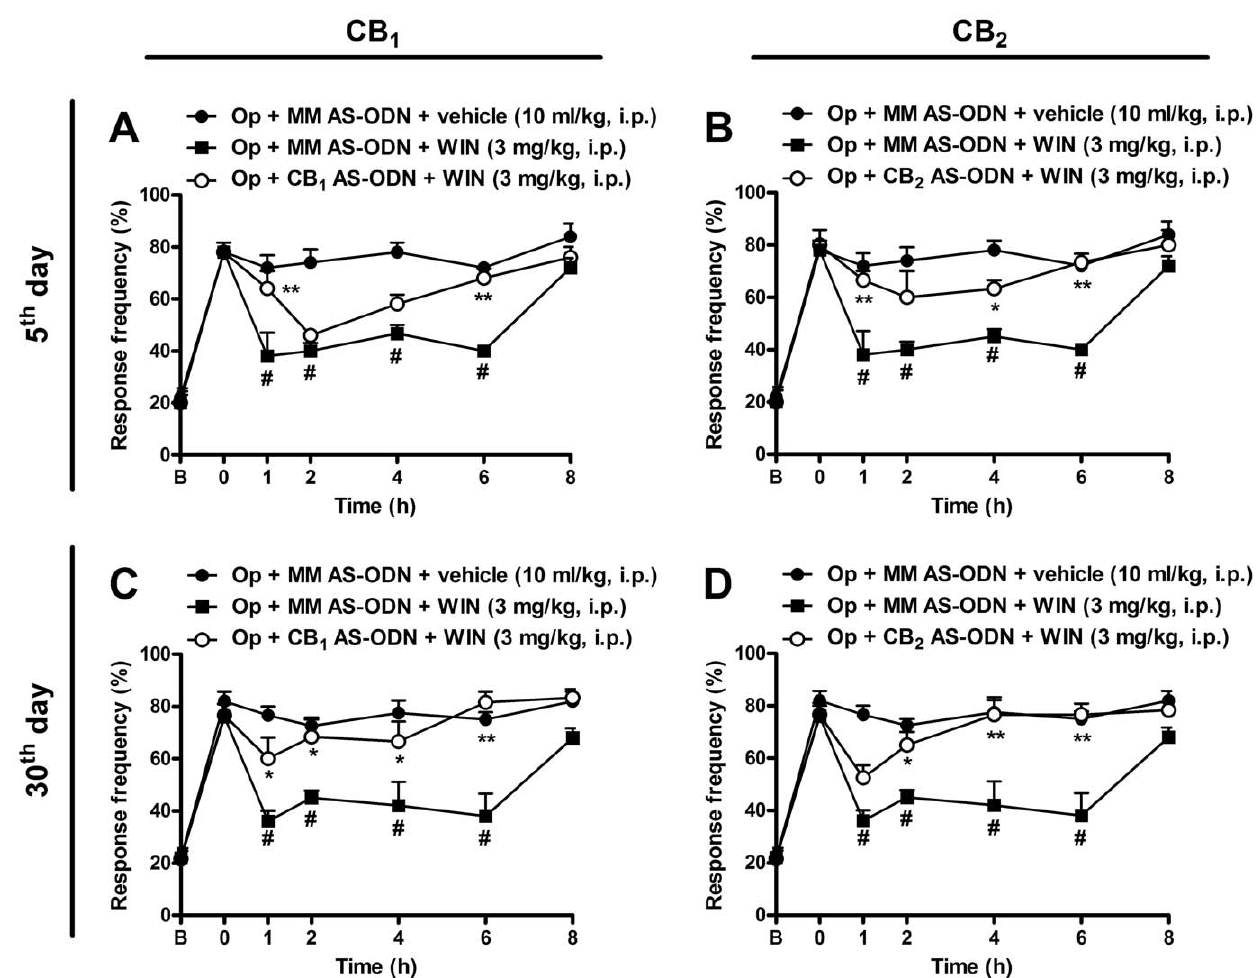
Figure 9. Effect of treatment with antisense oligodeoxinucleotide (AS-ODN) against the CB 1 or CB 2 receptor on mechanical allodynia induced by brachial plexus avulsion (BPA) in mice. Different groups of operated (Op) mice received an i.t. injection twice daily of mismatch AS-ODN (12.5 m g/site), CB 1 AS-ODN (12.5 m g/site) or CB 2 AS-ODN (12.5 m g/site). Systemic administration of WIN 55,212-2 (3 mg/kg, i.p.) produced a significant reduction of mechanical allodynia induced by BPA on the 5 th (A and B) and 30 th (C and D) days after surgery. The antinociceptive activity of WIN 55,212-2 (3 mg/kg, i.p.) was inhibited by both CB 1 AS-ODN (12.5 m g/site, i.t.) and CB 2 AS-ODN (12.5 m g/site, i.t.) on the 5 th (A and C) and 30 th (B and D) days after surgery, respectively. AS-ODN were administered on three consecutive days starting on the 2 nd and 27 th days after BPA surgery. The mice which received mismatch (MM) AS-ODN demonstrated similar responses throughout the testing period. Data are expressed as mean 6 SEM (n=4–6/group). *p , 0.05 and **p , 0.01, significantly different from the operated group that received MM AS-ODN and treated with WIN 55,212-2 (two-way ANOVA with Bonferroni’s post hoc test). # p , 0.01, significantly different from operated-mice group (Op) that received MM AS-ODN and treated with vehicle. B, Baseline withdrawal threshold before surgery. 0, baseline withdrawal threshold after surgery on the day of the experiment (5 th and 30 th days).